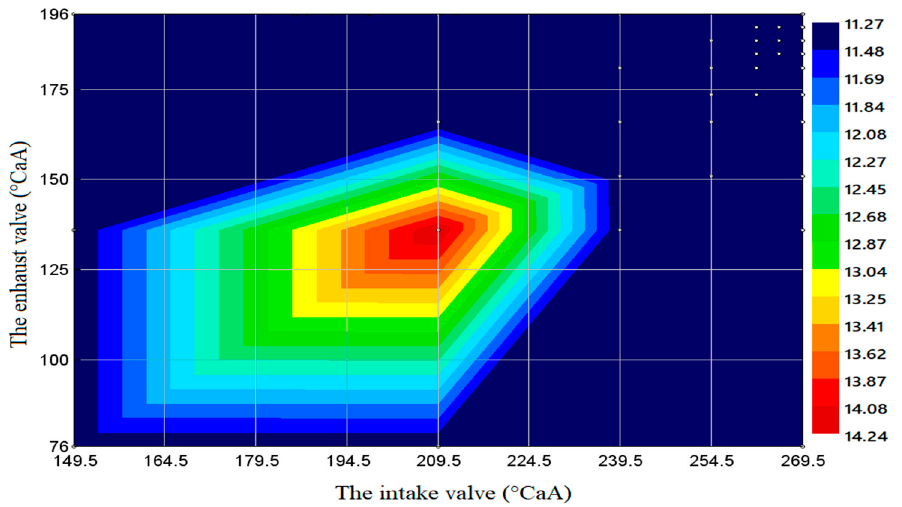
Figure 19. 50% load